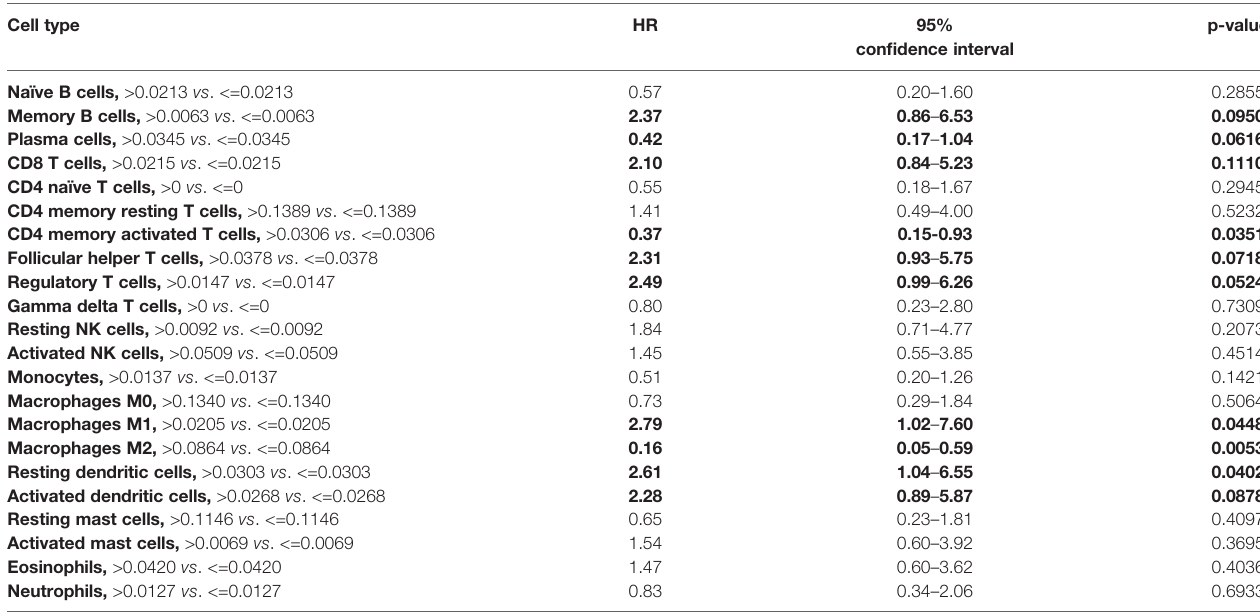
TABLE 3 | Cox proportional hazards models for CIBERSORT